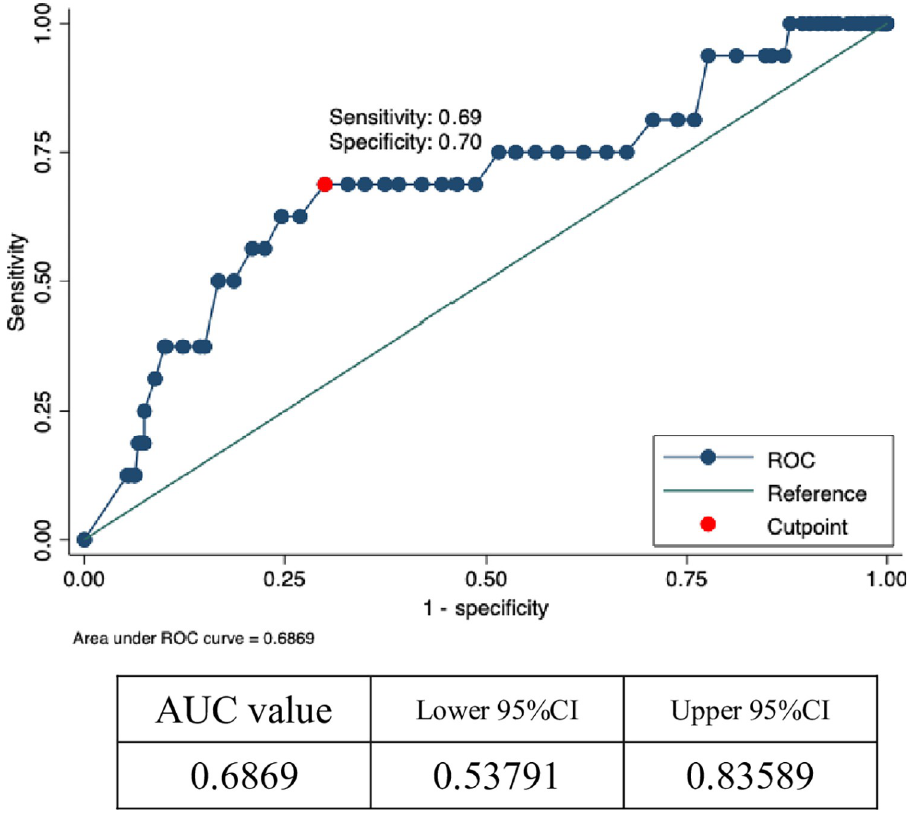
Fig 3. ROC curve analysis of resistance index in patients with